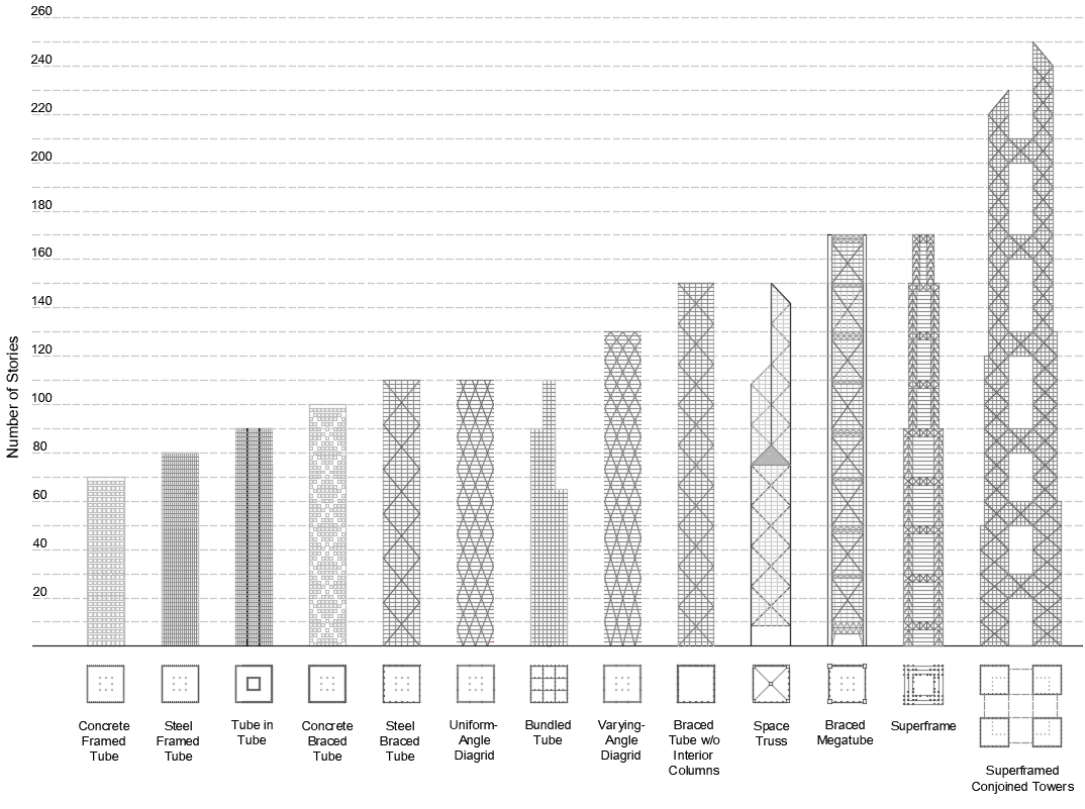
Figure 3. Classification of tall building structural systems by authors.